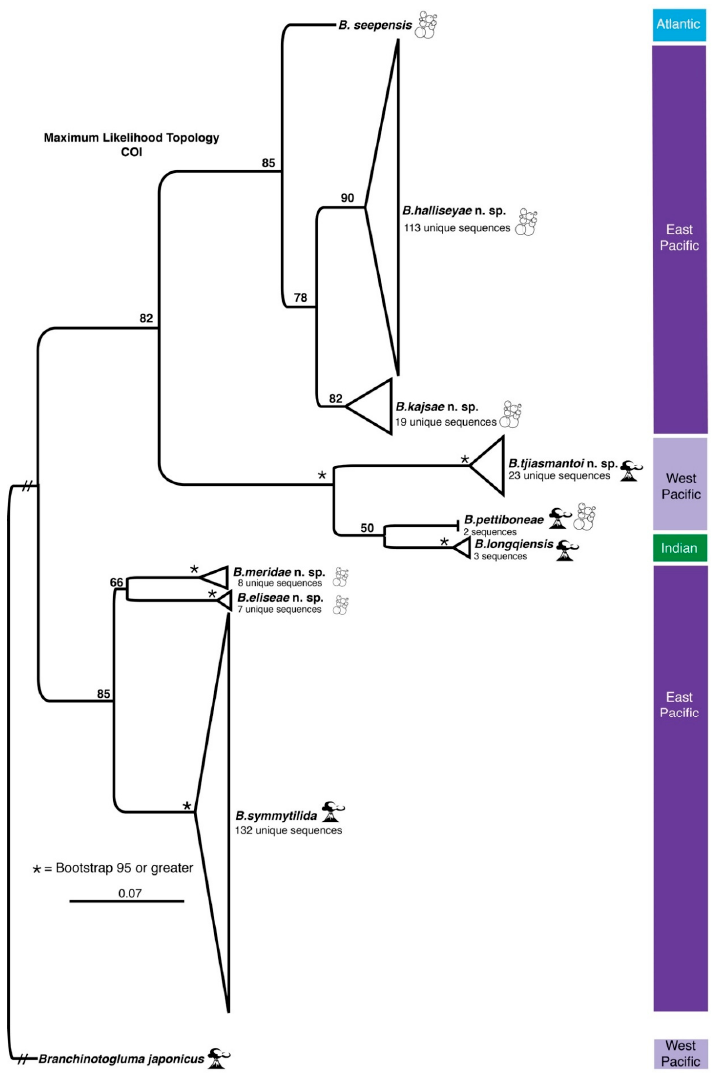
Figure 1. Maximum likelihood tree from the unique Branchipolynoe COI sequences from each of the five new species from this study and GenBank, a total of 309 sequences, rooted with Branchinotogluma japonicus . The variation within each species is collapsed. Support on relevant nodes are bootstrap values. Asterisk, *, indicates 95% or greater.